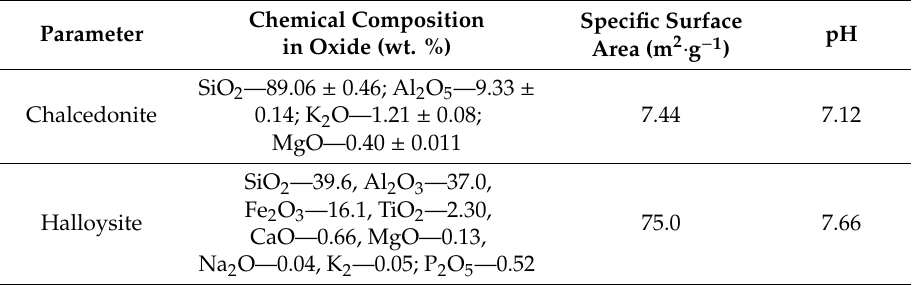
Figure 1. Scanning electron microscope (SEM) images of chalcedonite ( a ) and halloysite ( b ). Table 1. Properties of mineral ‐ based amendments.